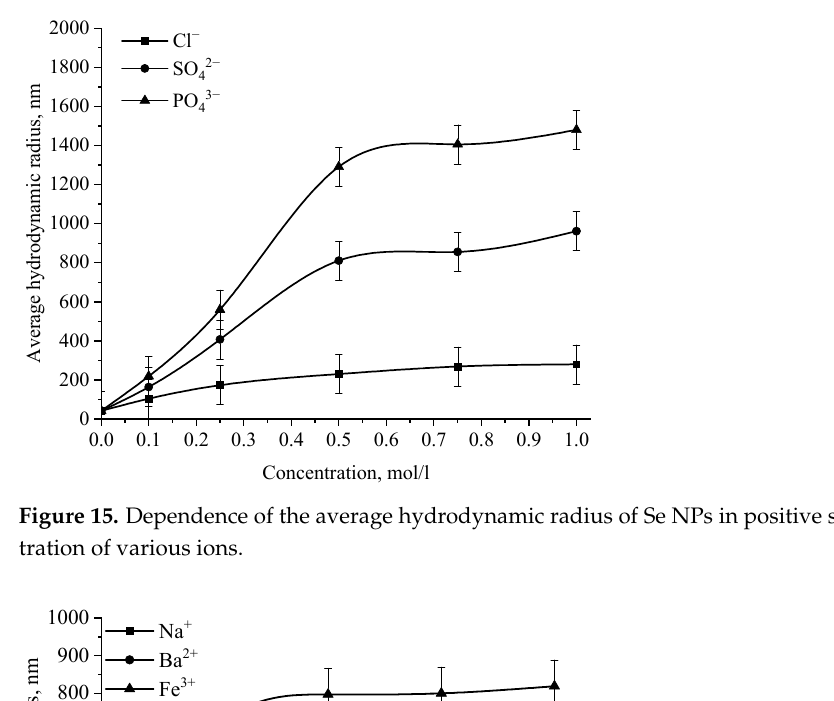
Figure 14. Dependence of the average hydrodynamic radius of Se NPs in negative sol on the con- centration of various anions.